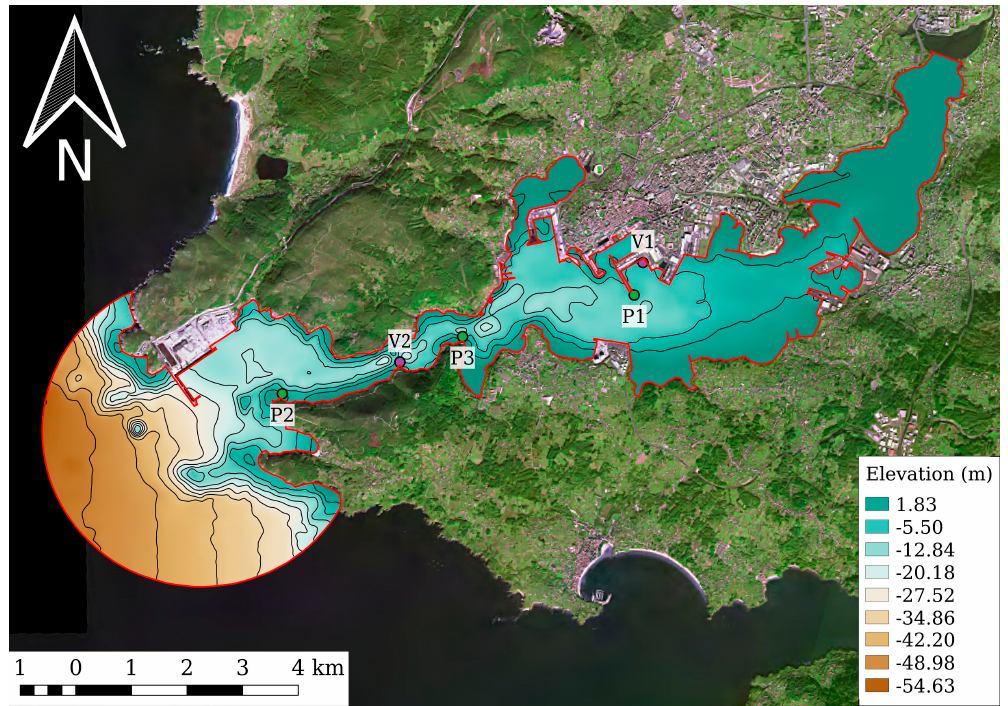
Figure 3. Bathymetry of the Ferrol estuary (NW, Spain). The sewage discharges are located at V1 and V2, whilst the control points are placed at P1, P2 and P3.